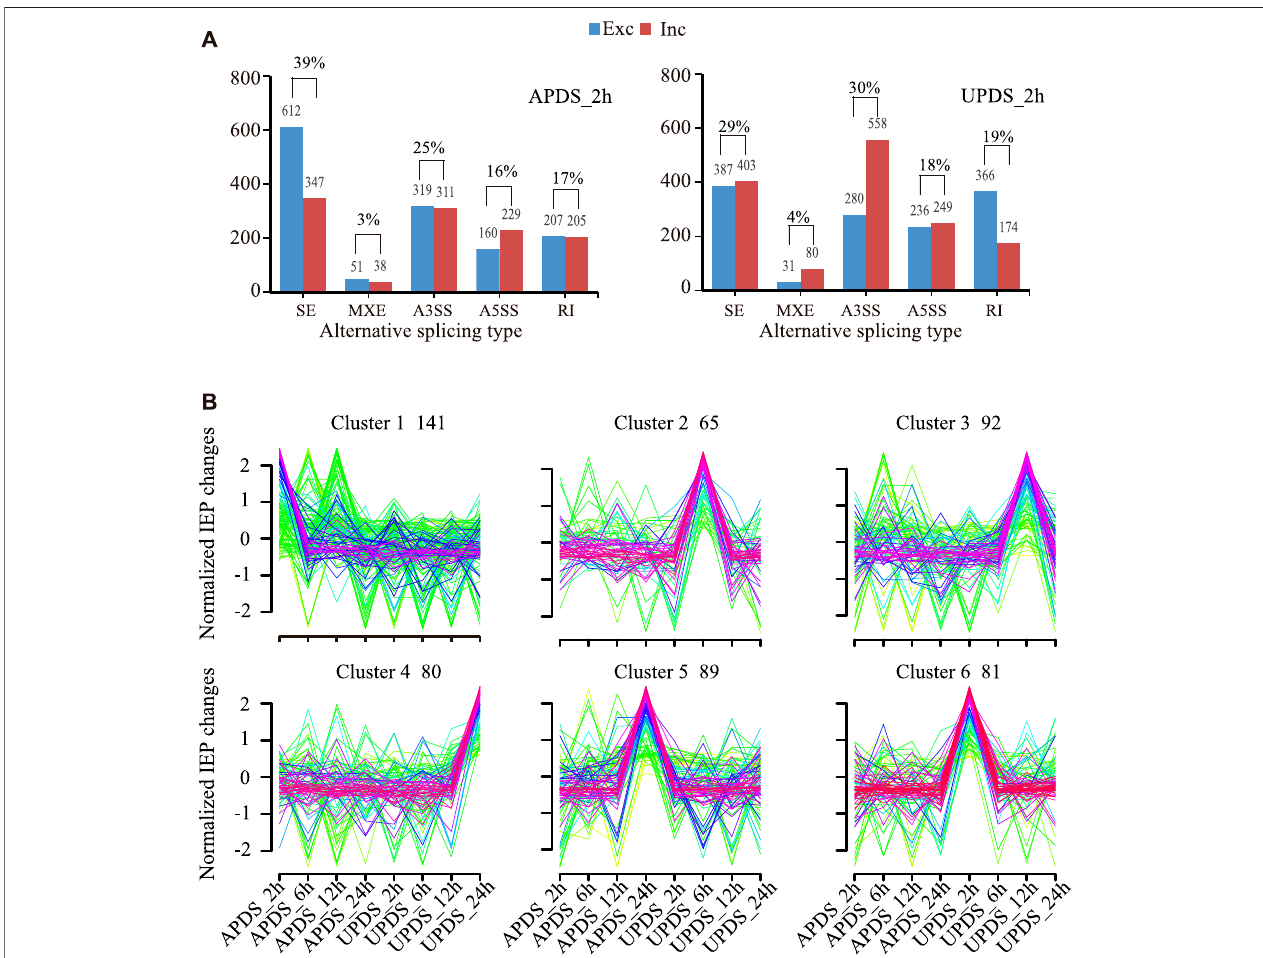
FIGURE3| Identi fi cationandcomparativeanalysisofstress-responsiveASeventsin G.uralensis . (A) ComparisonofnumberandproportionofdifferentASevents in different parts of G. uralensis . Exclusion is shown in blue, inclusion in red. y -axis shows number of AS events, x -axis shows types of AS events. (B) Cluster analysis of stress-responsive AS events in G. uralensis , as indicated by changes in isoform expression percentage (IEP) under various drought conditions. [IEP = mean PSI (ck)/ (mean PSI (ck) + mean PSI (stress)]. Number of AS events in each cluster is listed. x -axis shows various stress conditions and y -axis shows IEP values. Red line shows the trend of average IEP value for all AS events in each